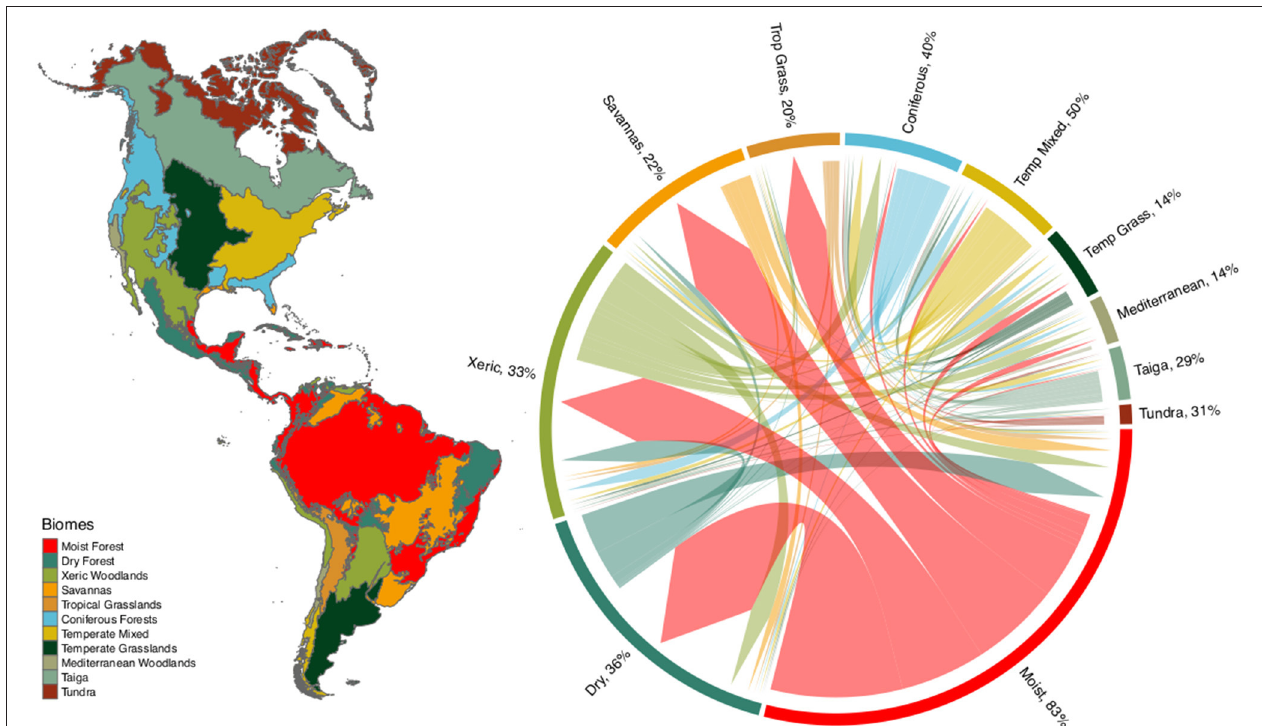
FIGURE 1 | Overlap of plant species among biomes of the New World. Percentage values express the fraction of species occurring in a biome that have the greatest proportion of their geographic range in that biome, N = 84,413. The base of each branched arrow is positioned to show the biome that includes the greatest proportion of a species range, while the width represents the number of species shared with the biomes at the tips of the arrow. See Supplementary Table 1 for the underlying